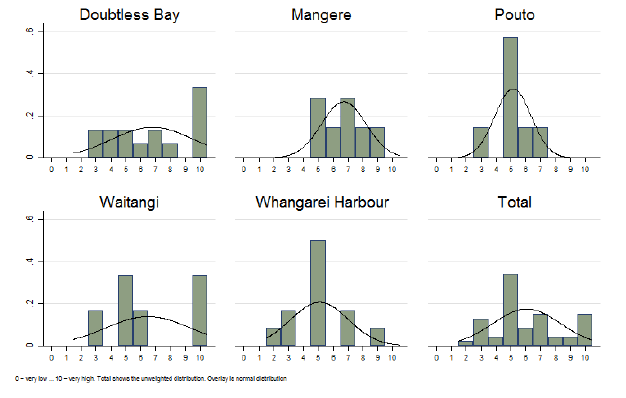
Figure A1.6 Results from the Northland processes at the same point in time, “The process adapts to new information and changing